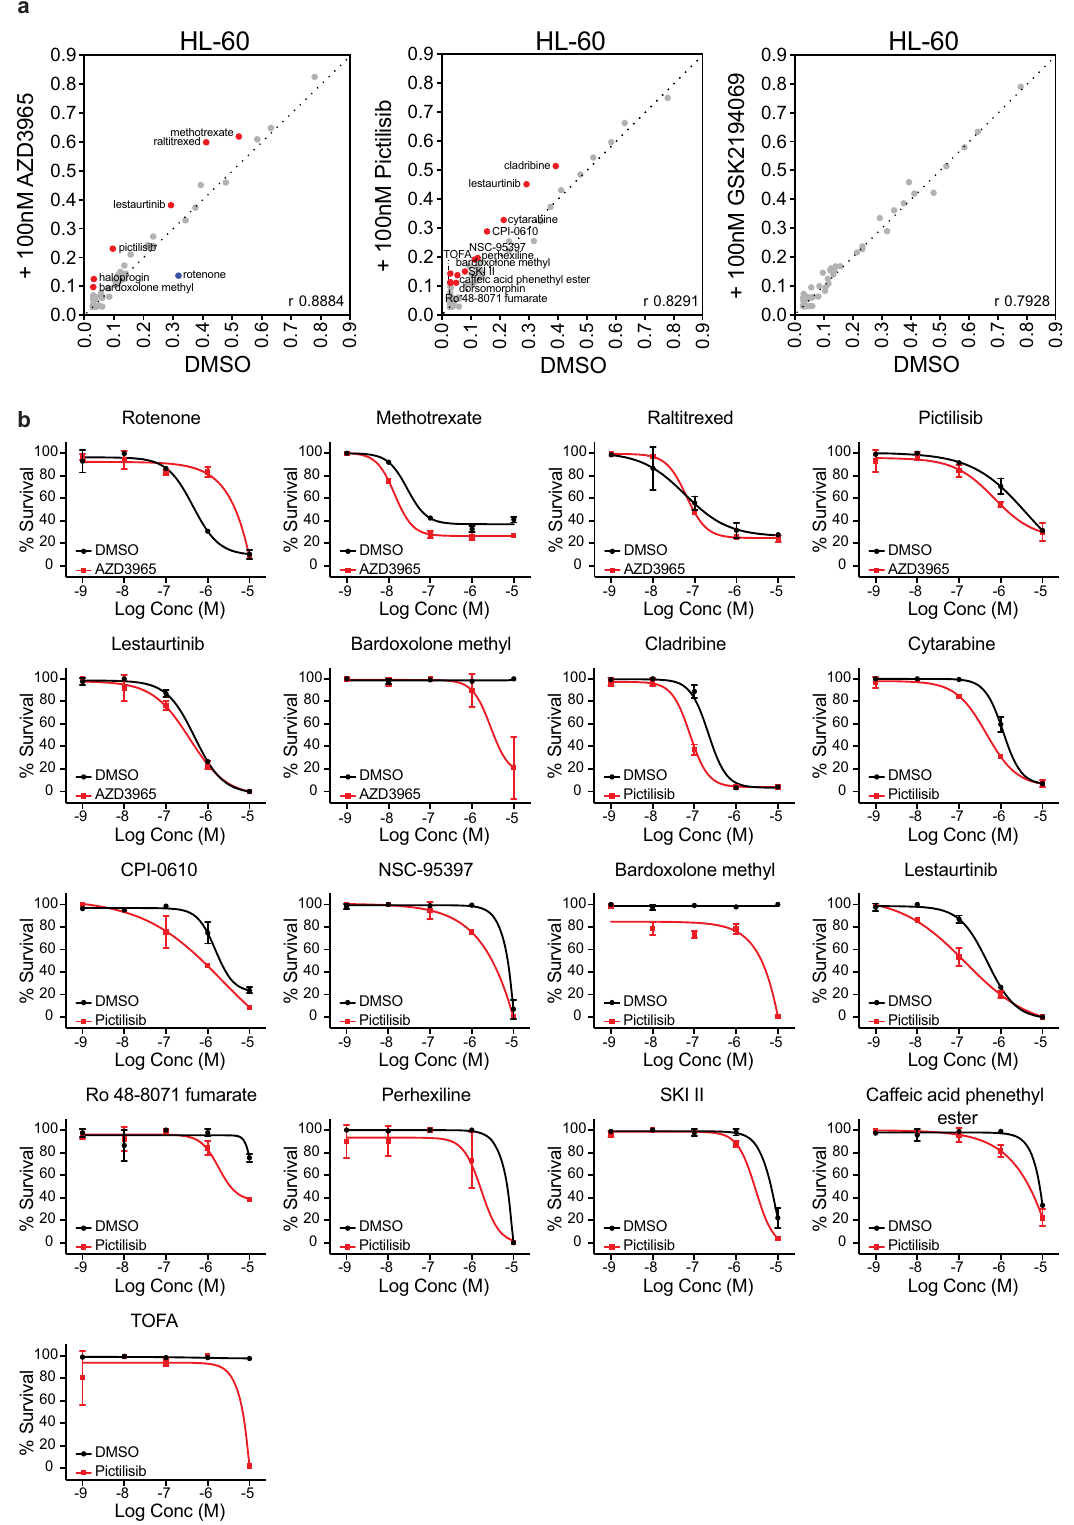
Fig. 8 Metabolic inhibitors can alter metabolic dependencies. a Spearman correlation of drug responses in HL-60 cells in response to 72 h 100 nM AZD3965, 100 nM pictilisib, or 100 nM GSK2194069 treatment quanti fi ed as AUC values. Drugs that showed a reduced sensitivity in response to drug treatment are marked in blue, whereas drugs that showed an increased sensitivity are marked in red. b Dose – response curves of the drugs highlighted in a as percentage survival. Black curves are baseline and red curves are in response to the respective drugs. Error bars indicate standard deviation of the mean of technical